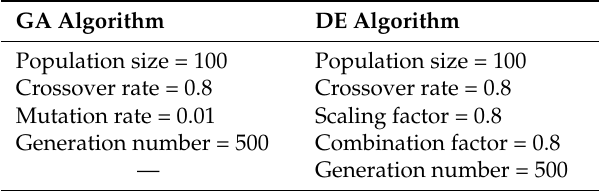
Figure 8. Frequency responses of the designed filters by the DE algorithm and the GA algorithm. Table 4. The parameters of GA and DE